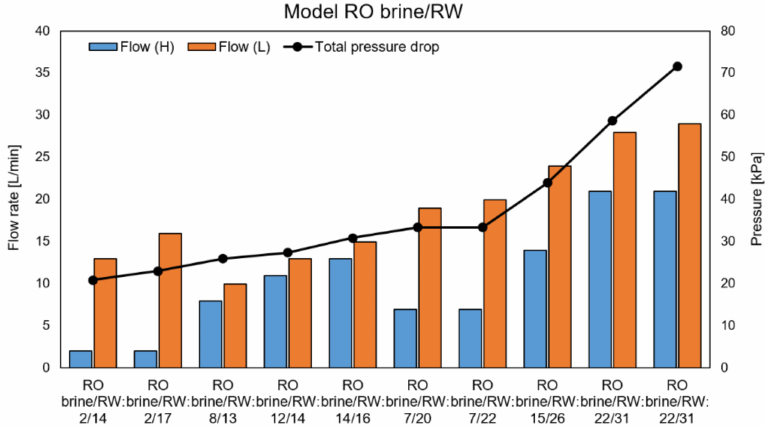
Figure A10. Pressure drops of RED stack as a function of the feed flow rate using model RO brine/RW.